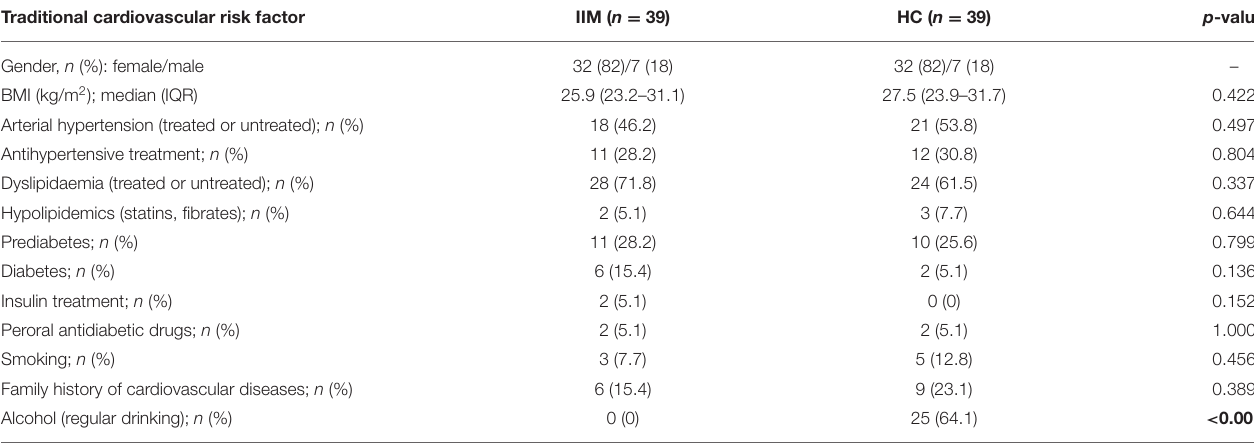
TABLE 2 | Comorbidities and traditional cardiovascular risk factors in IIM and